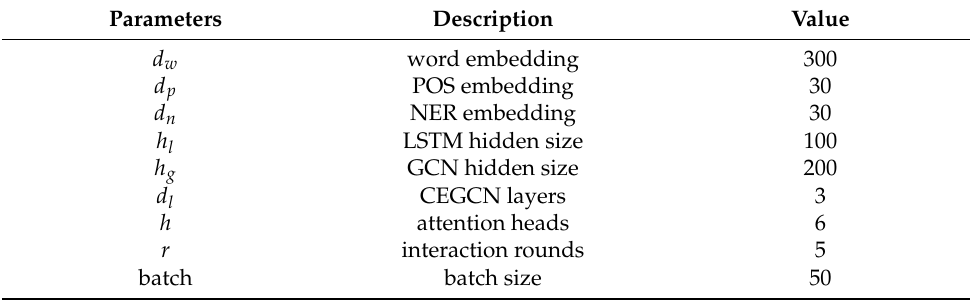
Table 1. Hyperparameters of the model for both datasets.